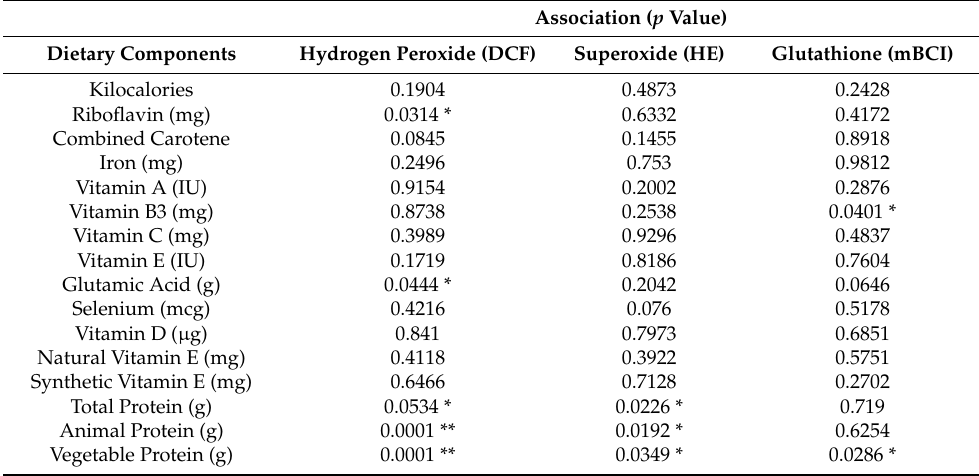
Table 4. Multi-level regression model examining the relationships between oxidative stress measures a and dietary components.